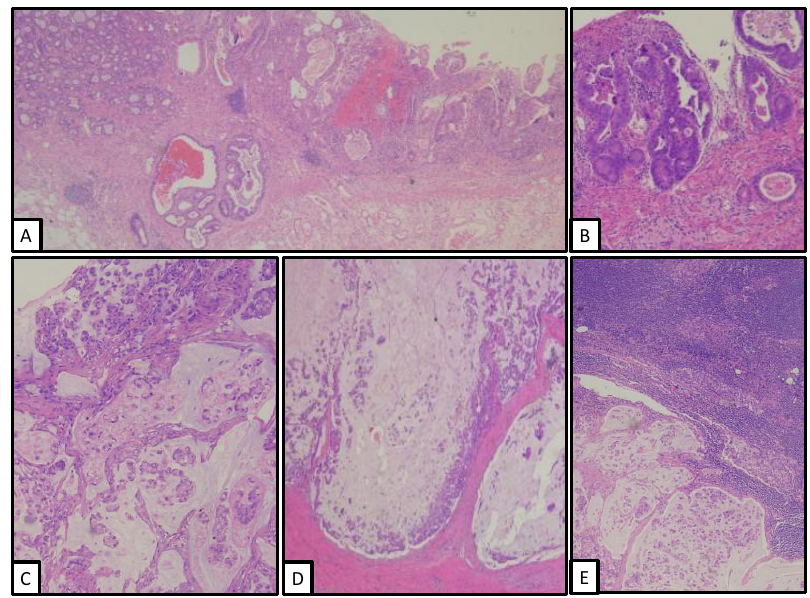
Figure 2. Low-power view of small bowel adenocarcinomas associated to Brunner’s gland agenesia. Both, superficial low-grade adenocarcinoma ( A , B ), and invasive and lymph node metastasizing high-grade adenocarcinoma with signet-ring cell histology ( C – E ).